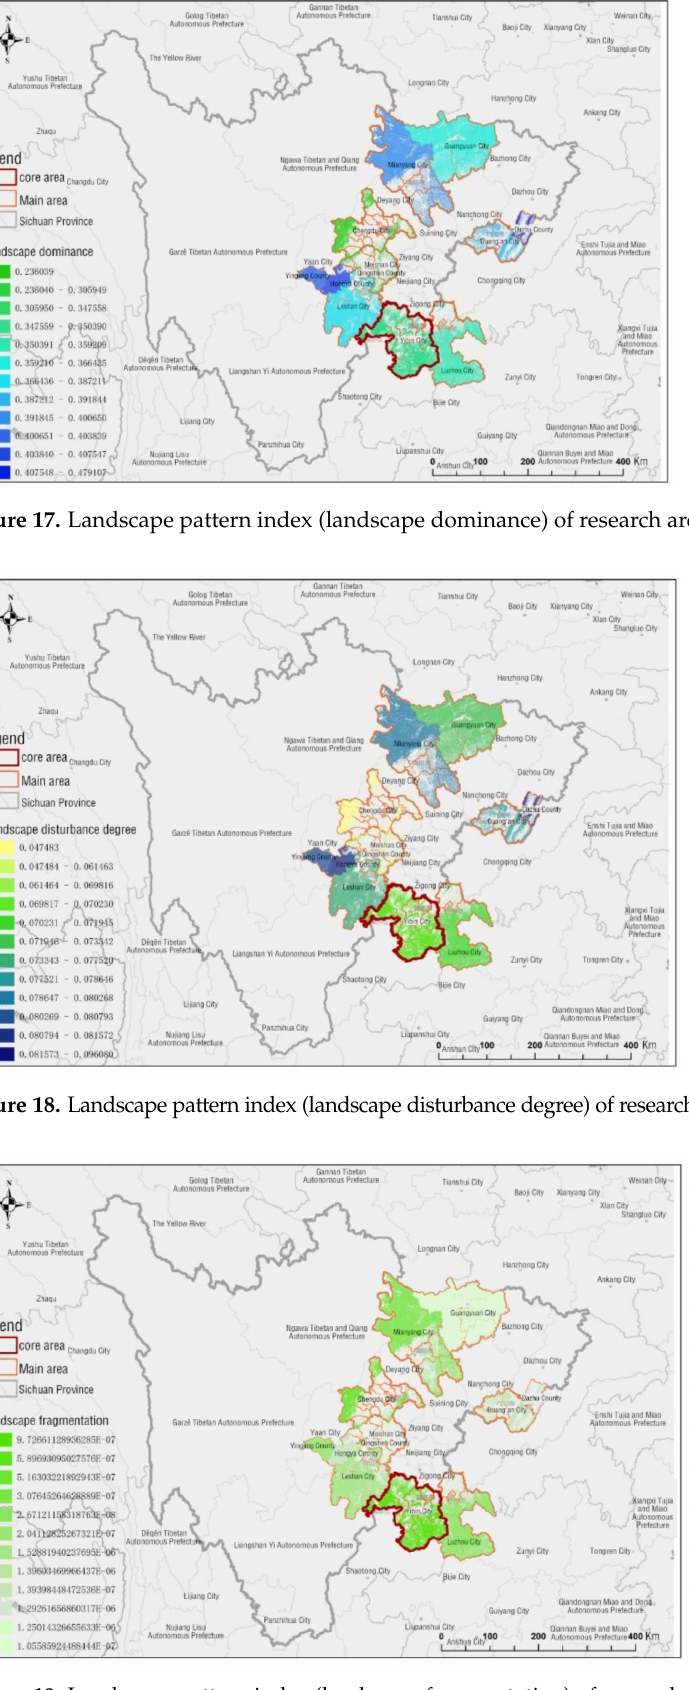
Figure 19. Landscape pattern index (landscape fragmentation) of research areas in Sichuan